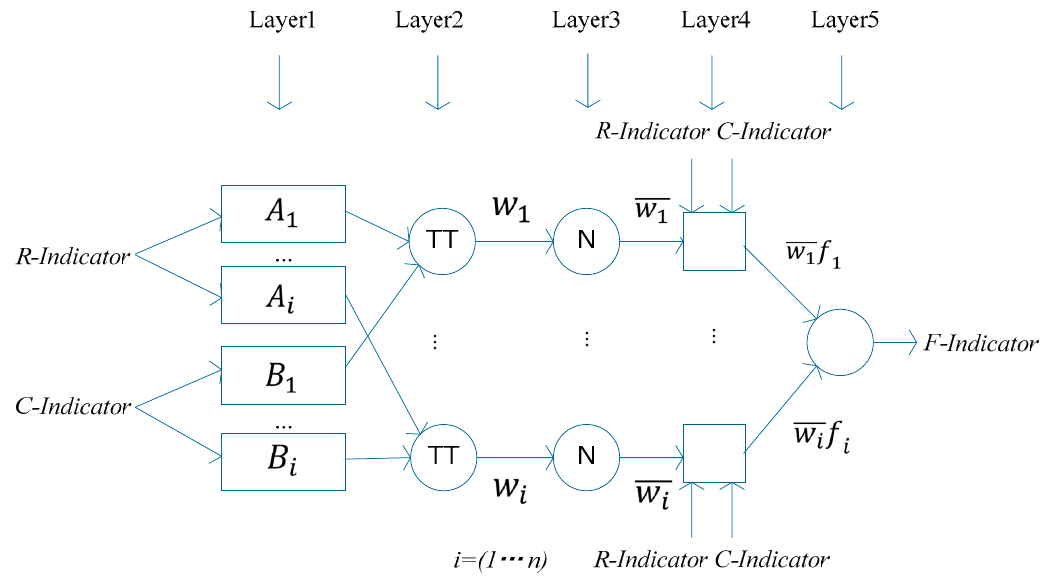
Figure 2. The structure of the designed ANFIS-based fault detection system.